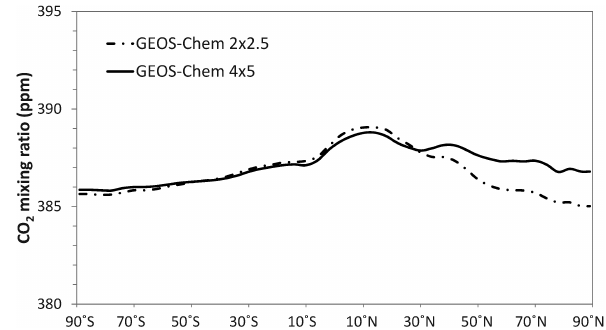
Figure 12. Latitudinal cross section of zonal mean CO 2 at 12km on 1 April 2010 from the GEOS-Chem 4 ◦ × 5 ◦ and 2 ◦ × 2.5 ◦ sim-